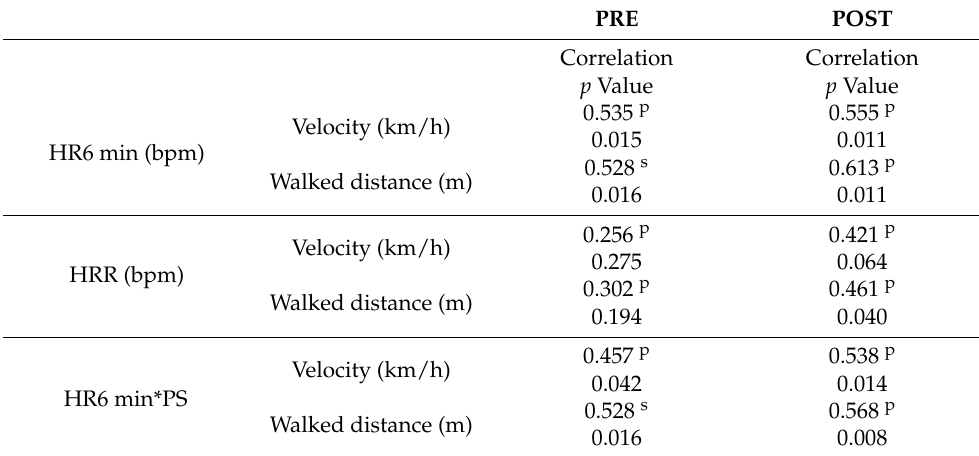
Table 5. Relationship of the products of heart rate and speed and walked distance in the 6 MWT before and after a pulmonary rehabilitation